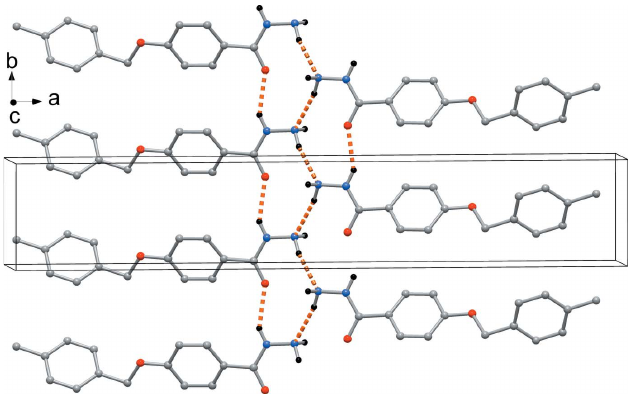
Figure 5 The layered arrangement in the crystal packing of (I) caused by